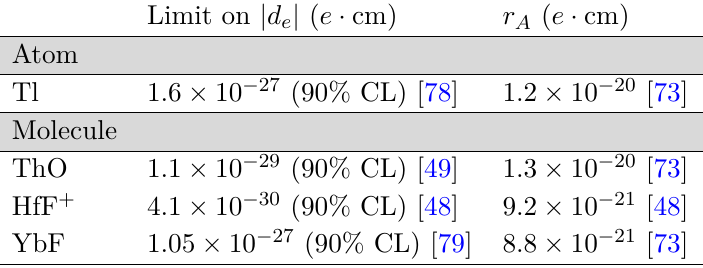
Table 1 . Limits on